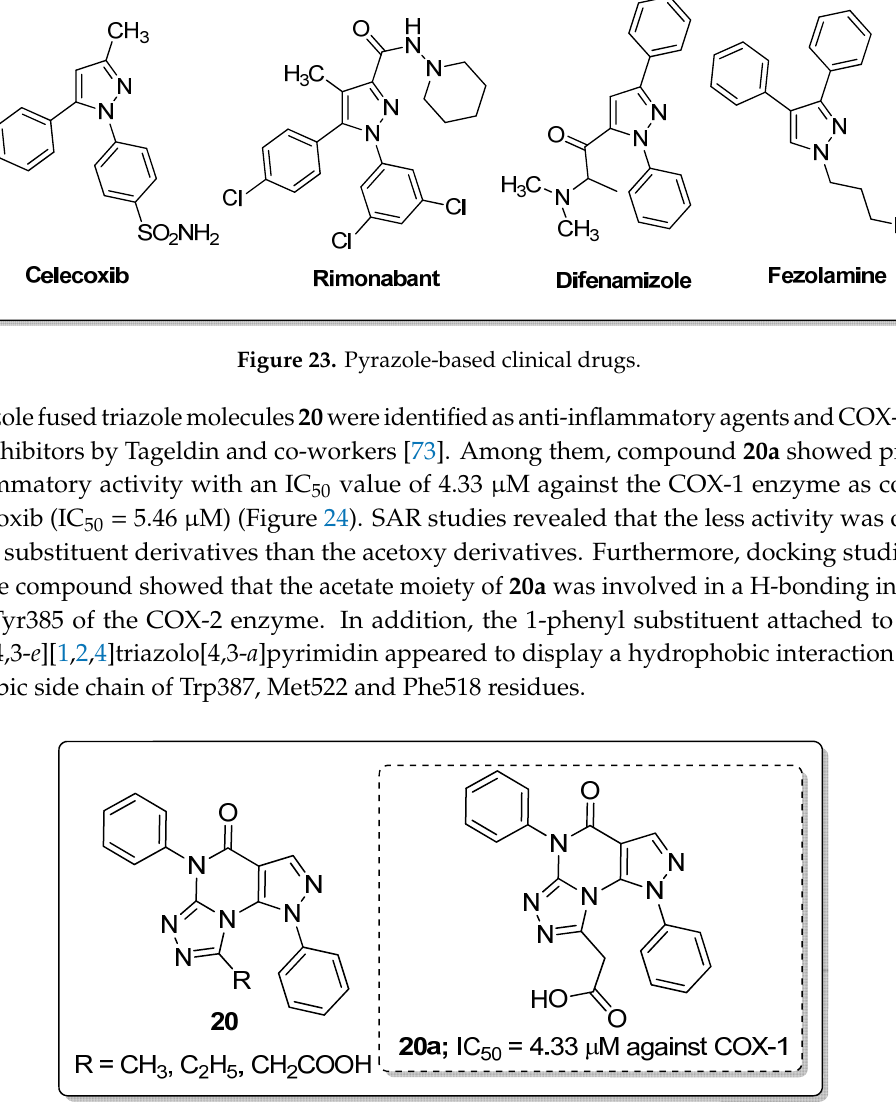
Figure 25. Anti ‐ inflammatory activity of the most active pyrazole sulfonamide conjugate 21a . Furthermore, the binding mode of the active compound 21a was evaluated by molecular docking studies, where the negatively charged carboxylate moiety at the position 3 of the pyrazole compound was shown to be anchored in the active site through ionic interaction with the positively charged non ‐ heme iron. Through hydrophobic interaction, the aryl substituent at position 5 interacts with the hydrophobic side ‐ chains of the amino acids Leu368, Leu414, Ile415 and Phe421. In addition,